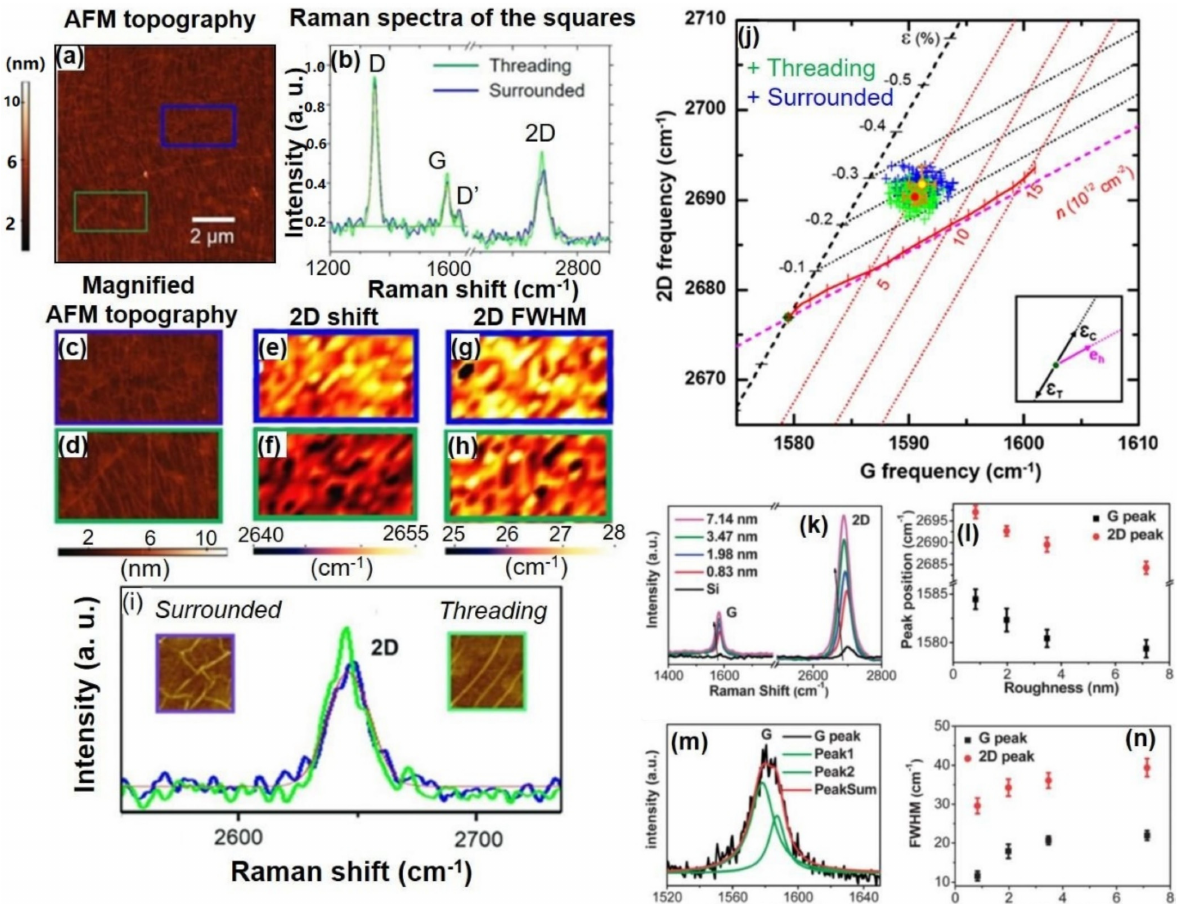
Figure 5. ( a ) The AFM image of CVD-MG on Au film was shown. The regions marked with blue and green squares clearly revealed different RP shapes such as the surrounded and ( c , d ) threading type, respectively. It is noticed that the blue and green squares were completely correlated in Figure 5, particularly the square boundary color in ( c – i ) including spectra color. ( b ) The representative Raman spectra at each colored domain were shown. The blue and green Raman spectra correspond to the surrounded and threading regions, respectively, Lorentzian curve fitting shown as red color, with focus on blue (threading) domain and green (surrounded) in ( i ). The ( e )/( f ) and ( g )/( h ) images showed the correlative maximum peak position and FWHM of 2D mode Raman image for the different colored regions, respectively. It was clearly shown that the 2D FWHM of the green domain showed a smaller value than the blue, which indicates that the threading type ripples (RPs) displayed relatively stable structure. The inference is also supported by the lower FWHM value and the relative red-shift than that of the surrounded. ( i ) The representative Raman spectra of each RP shape of CVD-MG were displayed (blue and green were also the surrounded and threading type, respectively) and the corresponding RP shapes were also shown in the inset of ( i ) with the coincided color. Reprinted with permission from [33]. ( j ) Correlation graph for different types of RP on CVD-MG. Correlation between G and 2D modes of the surrounded ripple (blue symbols) and threading (green symbols) were shown. Inset: arrows marked as ε C , ε T , eh represent vectors from the zero point ( ω G0 , ω 2D0 ) affected by compressive strain, tensile strain and hole doping, respectively. ( k ) Raman spectra of CVD-MG on the Ag thin films as a function of roughness. It showed evident red-shift of peak position for both G peak and 2D peak. ( m ) Split of the Raman G peak of graphene on the Ag film of roughness about 3.47 nm. ( l ) Positions of G and 2D peaks based on Ag film roughness. ( n ) Full width at half maximum (FWHM) of G and 2D peaks with respect to Ag film roughness. Reprinted with permission from ref.